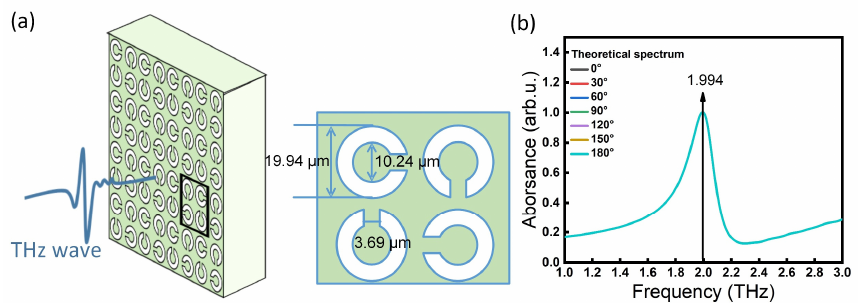
Figure 2. Polarization ‐ independent THz SPR biosensor. ( a ) Structural unit parameters of the SPR biosensor. ( b ) Theoretical response spectra of the THz SPR